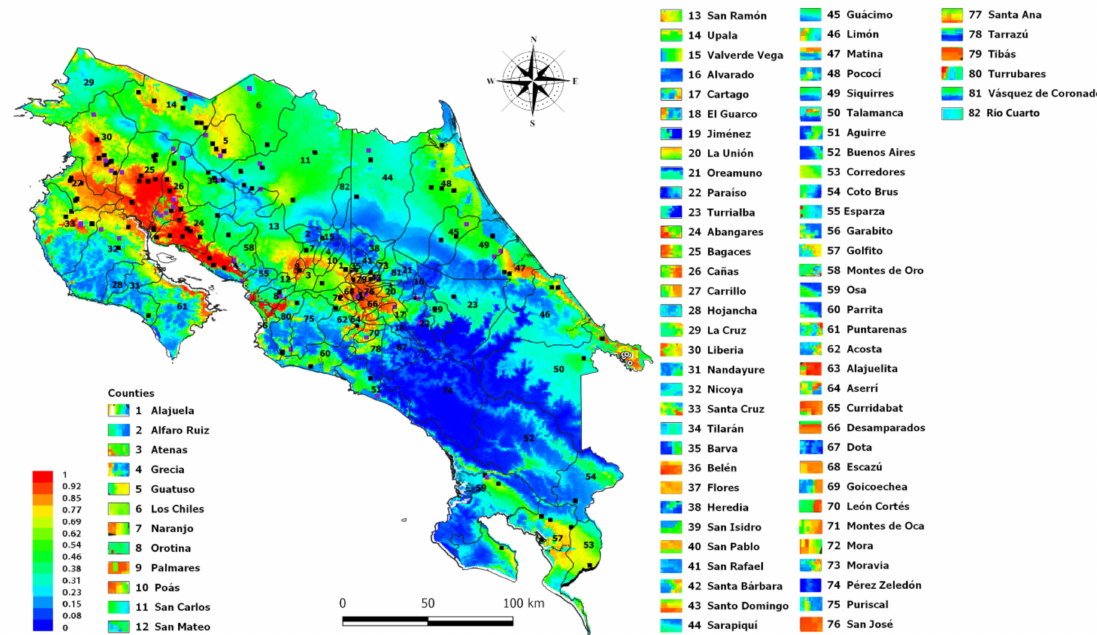
Figure 5. MaxEnt output map represented the suitability of VEEV outbreaks by each of the 82 Costa Rica’s counties., The rectangles next to the county name (labels) represent the potential risk of VEEV presence in that